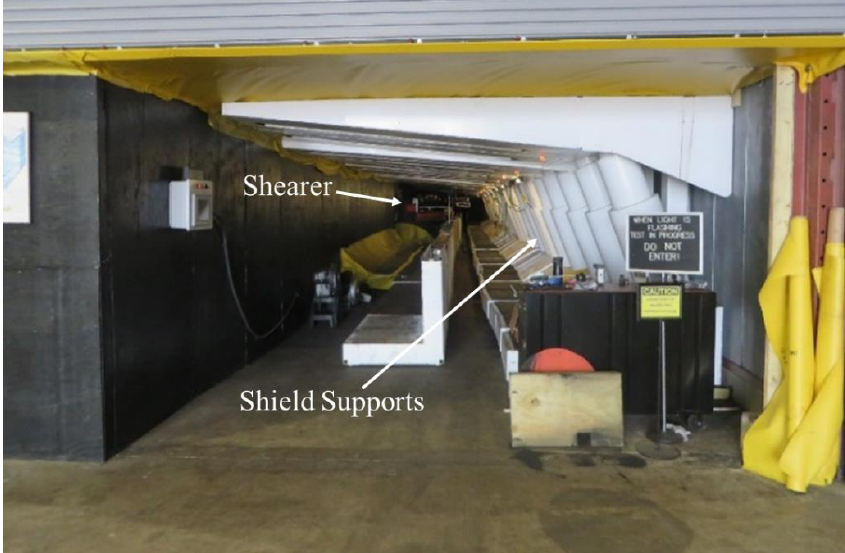
Figure 4. Longwall test gallery at PRL.